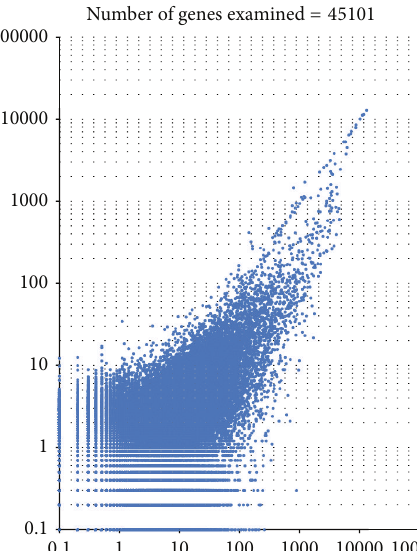
Figure 12: Gene expression in the lungs of mice infected with C. gattii TIMM 4097 and 4903 was measured and compared using microarrayanalysis.Themicroarrayanalysisdetectedtheexpression of 45,101 genes.